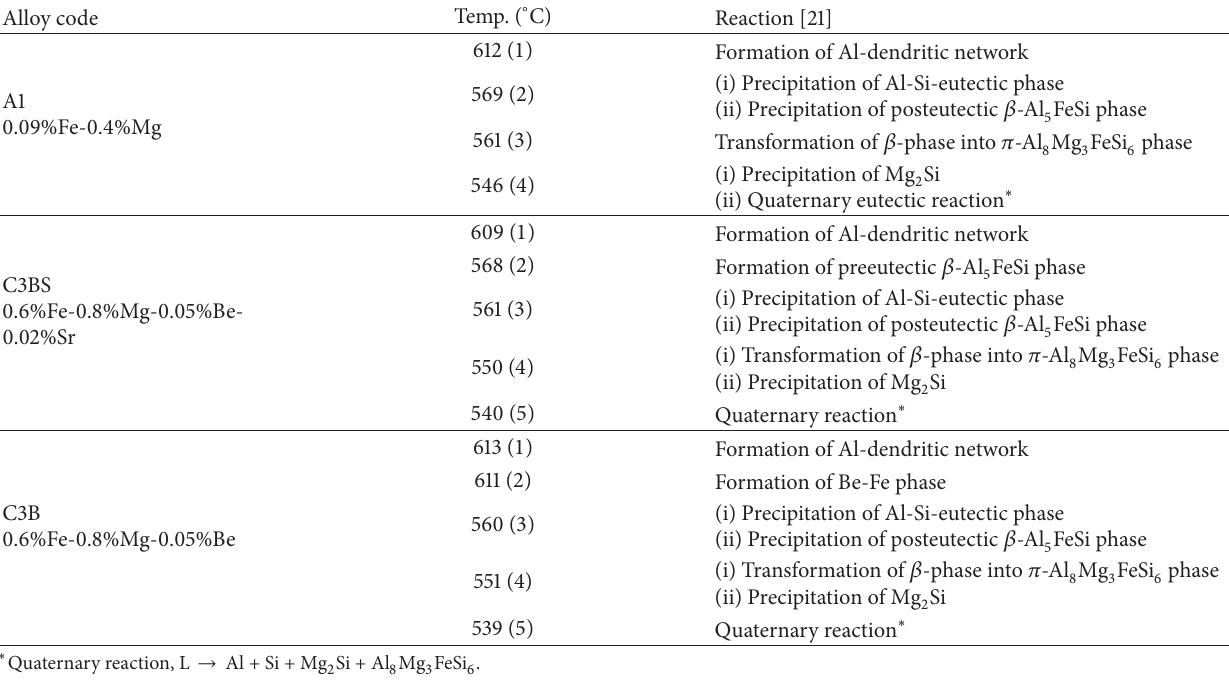
Table 3: Main reactions observed from thermal analysis data of alloys A1, C3BS, and C3B.